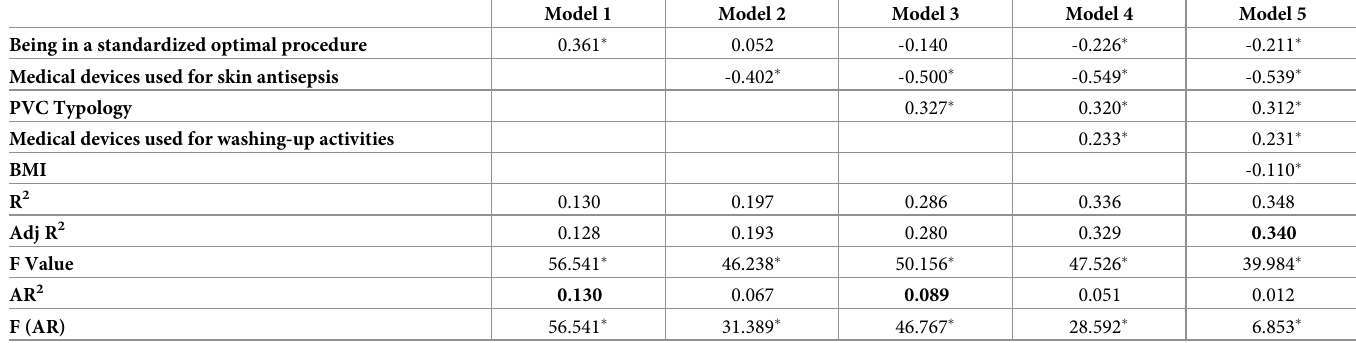
Table 4. Regression models for